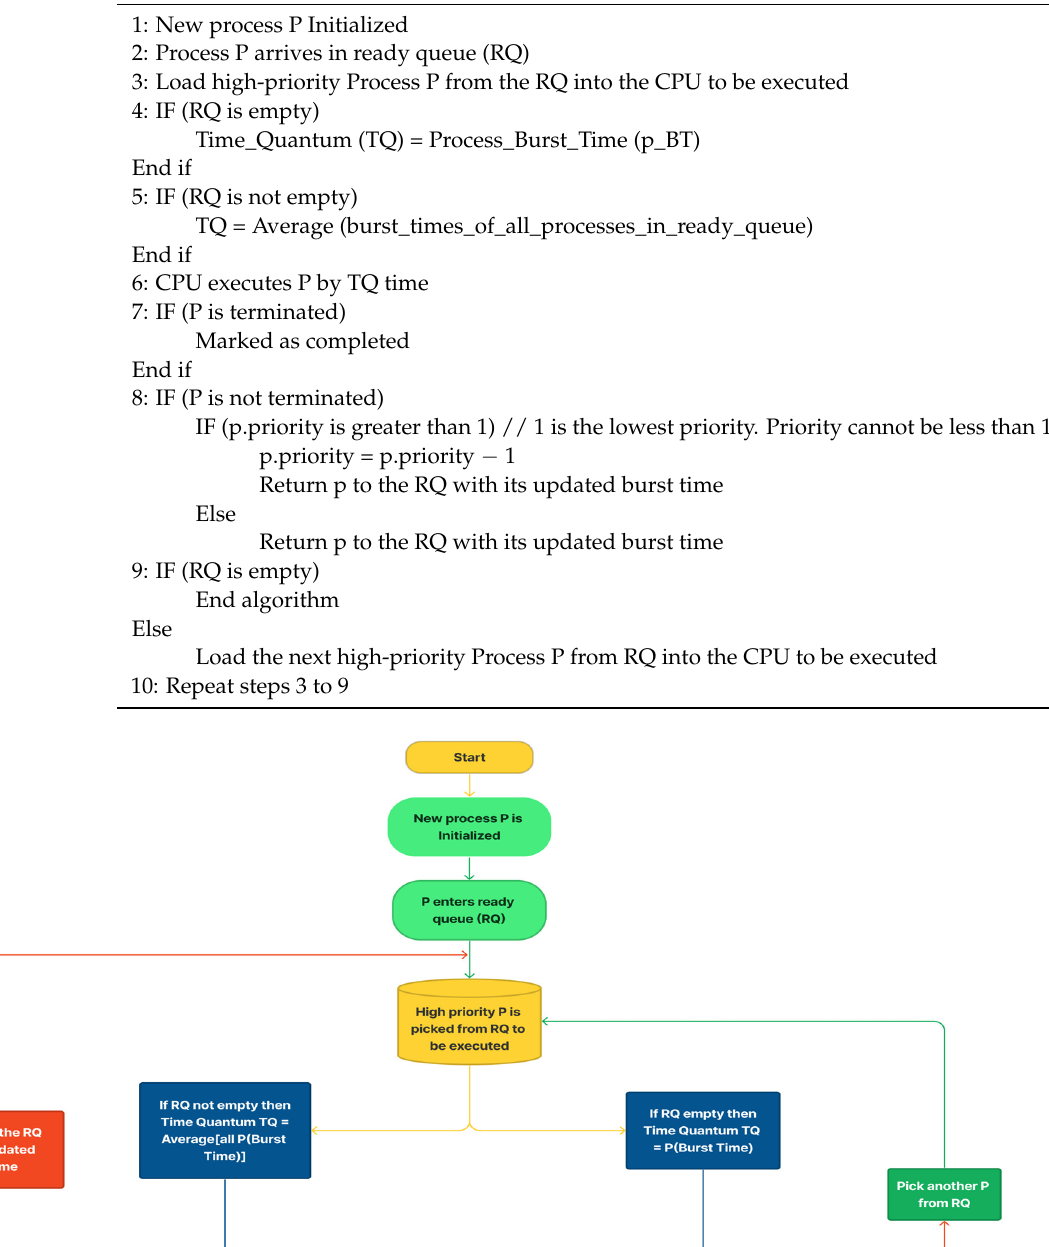
Algorithm 1 Round Robin with Adaptive Priority Scheduling (RRAPS)